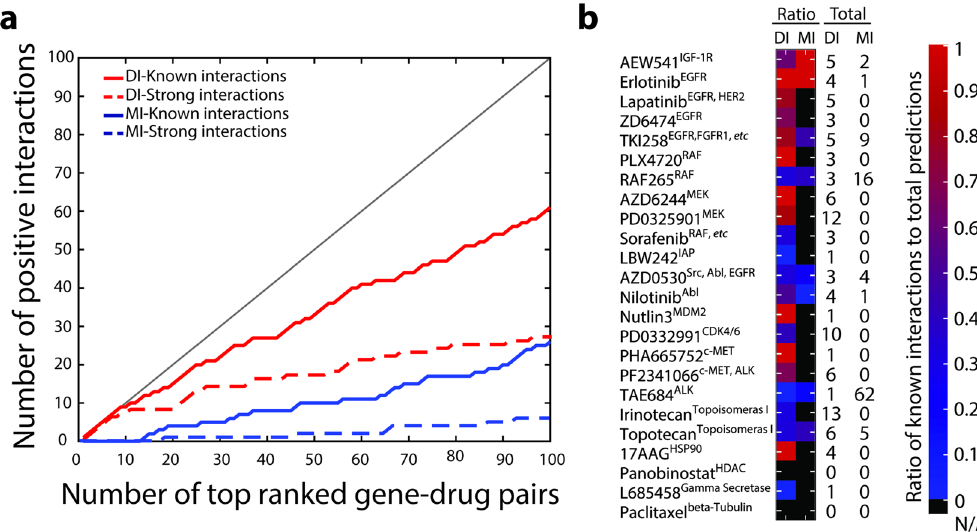
Figure 4. Direct Information as a metric in predicting gene mutation-drug response pairs. ( a ) Comparison between direct information and mutual information. Solid line plots indicate gene mutation-drug response pairs with known interactions (y-axis) against total number of drug-mutated gene pairs (x-axis) ranked by DI values (red) or MI (blue) values. Dash line plots indicate coupling pairs identified as strong interactions . ( b ) A heat map representation of ratios of known interactions to total predictions among pairs with top 100 DI values or MI values for each drug. The target(s) for each drug is shown in superscripts. The total numbers of gene mutation-drug response pairs captured by DI and MI for each drug are shown on the right of the heat map. Bars shown on the right in red denote high ratios and bars in blue depict low ratios. Bars in black indicate that the total prediction number in the top 100 pairs is